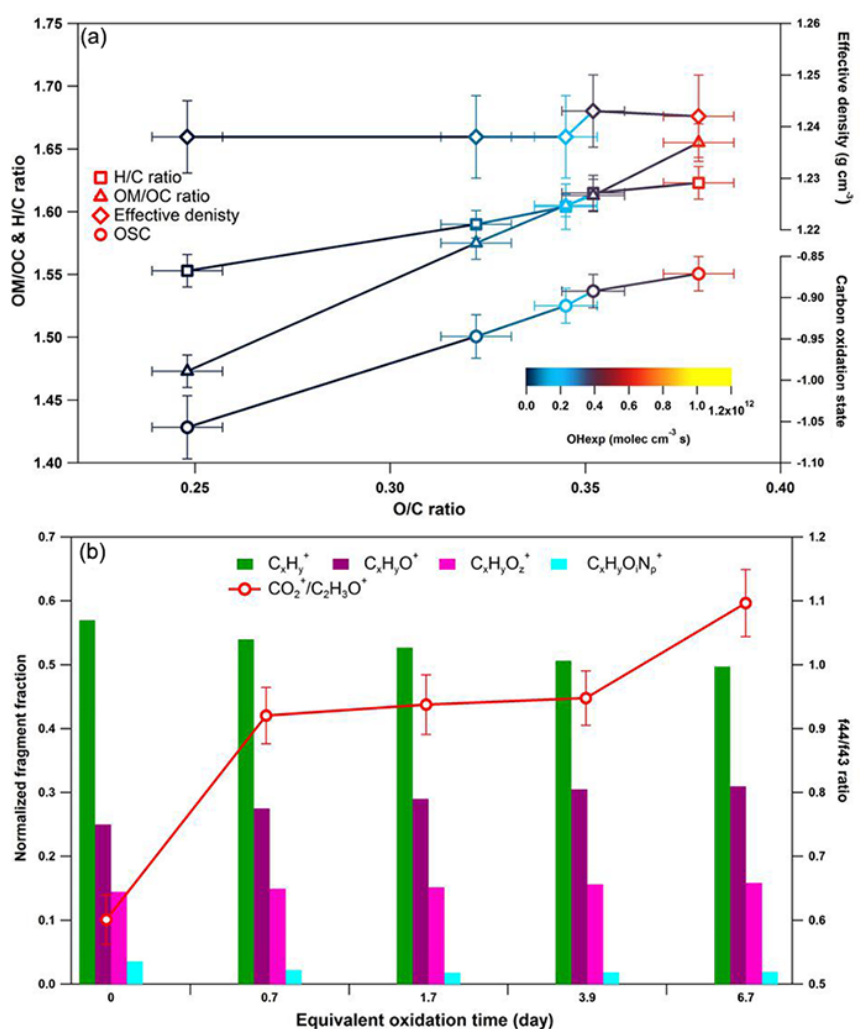
Figure 6. Dynamic changes for the chemical characteristics of tar ball particle under NO x -free OH photochemical oxidation: (a) OM / OC, H:C ratio, particle density, and average carbon oxidation state (OSc) changes as a function of O:C ratio; (b) mass spectra evolution with oxidation times in term of C x H + y , C x H y O + , C x H y O + z , and C x H y O i N + p fragment